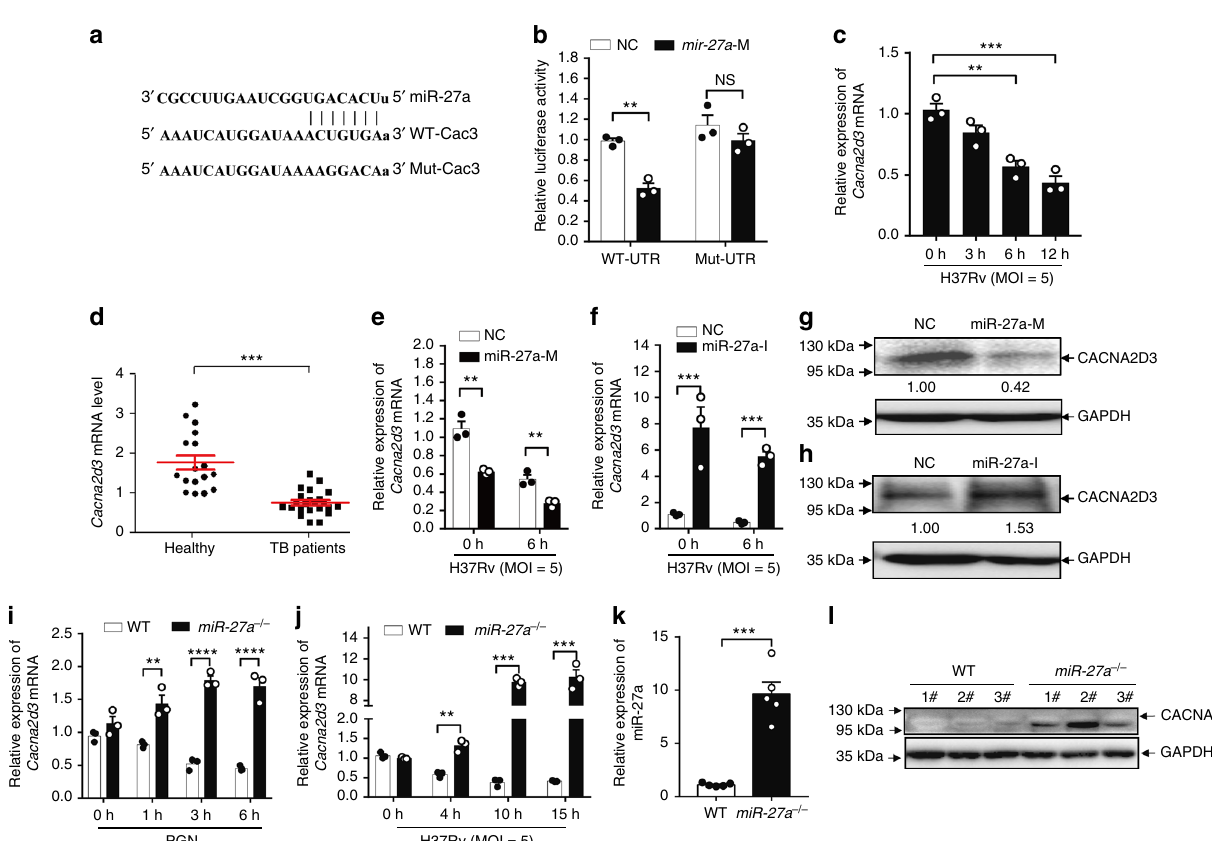
Fig. 3 miR-27a directly targets Cacna2d3. a Predicted binding sites of miR-27a and Cacna2d3 3 ′ -UTR. b Luciferase activity of HEK293T cells transfected with either WT or the seed sequence-mutated (mut) 3 ′ -UTR of Cacna2d3 plus scramble and miR-27a mimic. c – f Real-time PCR of the Cacna2d3 mRNA in: ( c ) macrophages infected with Mtb ; ( d ) PBMC from healthy donors and TB patients; ( e , f ) macrophages pre-treated with miR-27a-M ( e ) or-I ( f ), and then infected with Mtb . g , h IB of the lysates from macrophages pre-treated with miR-27a-M or miR-27a – I, and then infected with Mtb . i Real-time PCR of Cacna2d3 in WT or miR-27a -/- macrophages infected with Mtb . j Real-time PCR of Cacna2d3 in WT and miR-27a -/- macrophages treated with PGN for indicated times. k Real-time PCR of Cacna2d3 in lung tissues from WT and miR-27a -/- mice. l IB of lysates from WT and miR-27a -/- macrophages ( n = 3). NS, not signi fi cant ( p > 0.05), *p < 0.05, **p < 0.01, ***p < 0.001, and ****p < 0.0001 by the unpaired t -test ( b – f , i , j , k ). Data are from three independent experiments with biological duplicates in each ( b – f , i , j , k ; mean ± s.e.m. of n = 3 duplicates) or representative of three independent experiments ( g , h , l